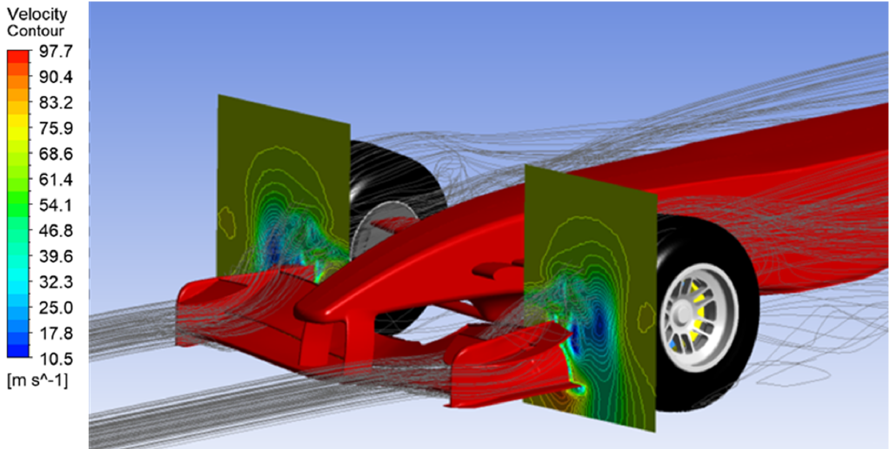
Figure 5. Streamlines around the car and velocity contour at the inlet of the reduced model.